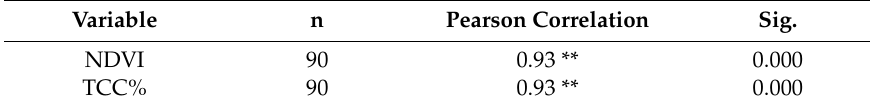
Table 8. Correlation between the canopy cover percentage and NDVI.